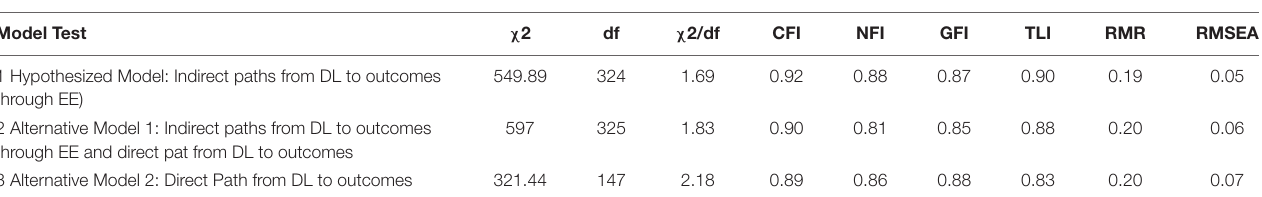
TABLE 3 | Comparison of alternative path models.